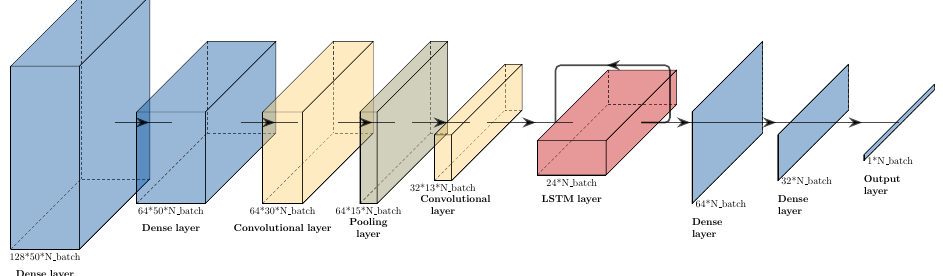
Figure 3. Structure of the neural network model, with layer types and sizes as indicated. N batch symbolises the variable dimension based on the number of